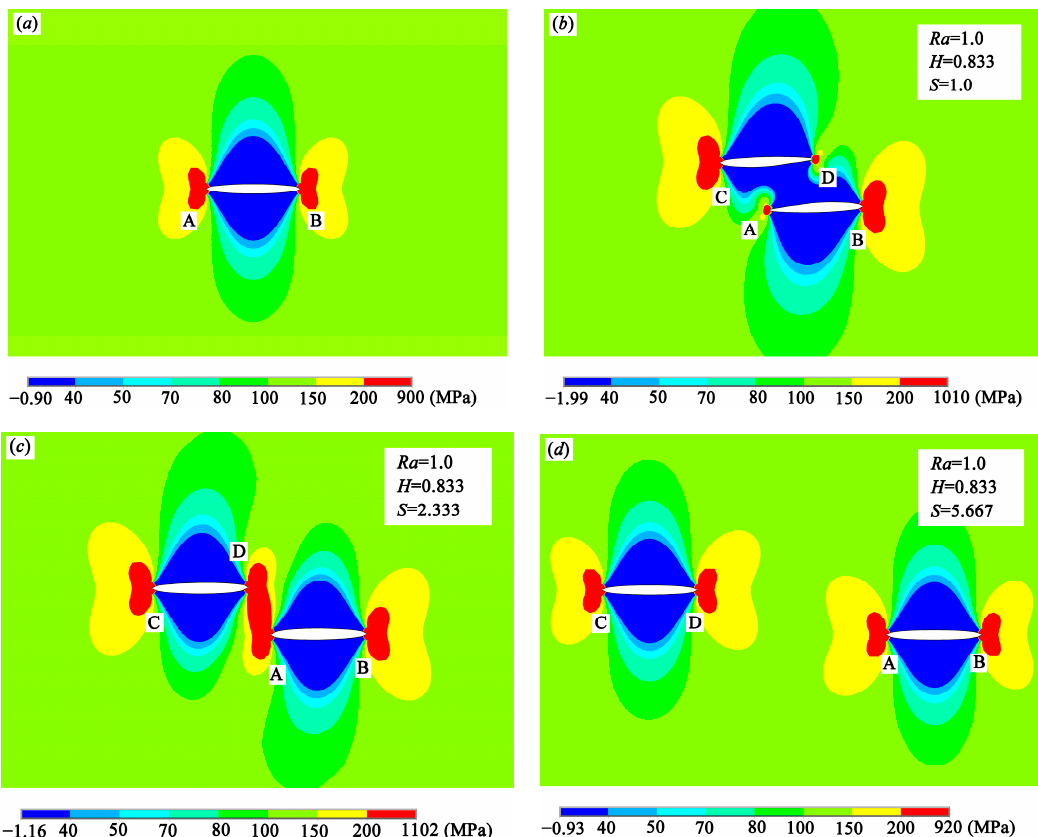
Figure 10. Tensile stress distributions around the crack tips: ( a ) single crack, ( b ) double cracks with S = 1.0, ( c ) double cracks with S = 2.333, and ( d ) double cracks with S = 5.667.